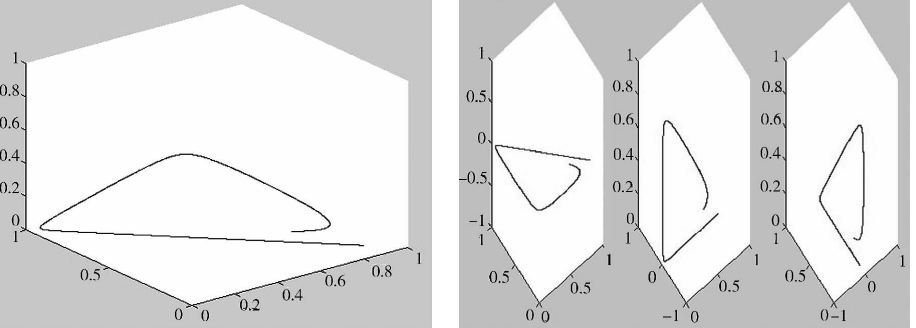
Fig. 6 Parameter a = -0.5 o’clock orbit